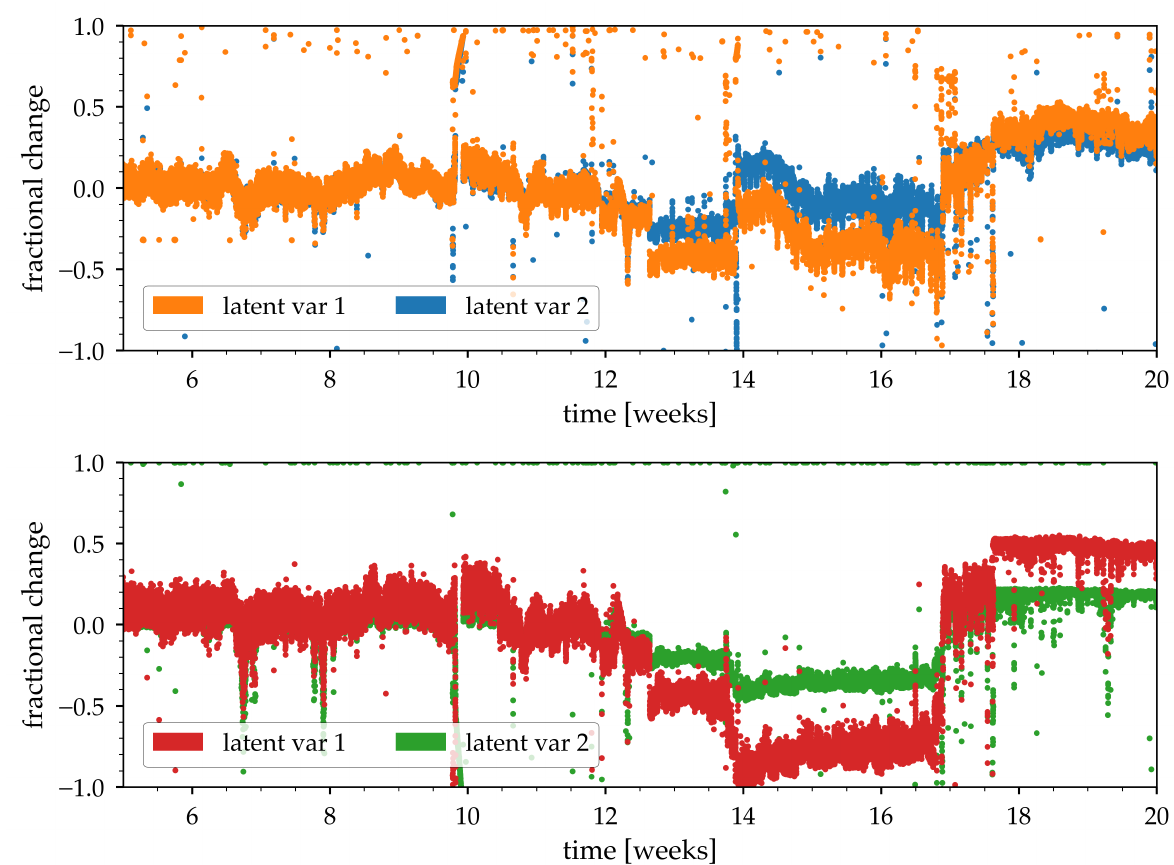
Figure 11. Fractional change in the encoded dimensions as a function of time. Top and bottom are autoencoders with the same architecture but with different random initial weights. The same training and validation set were used to train these two